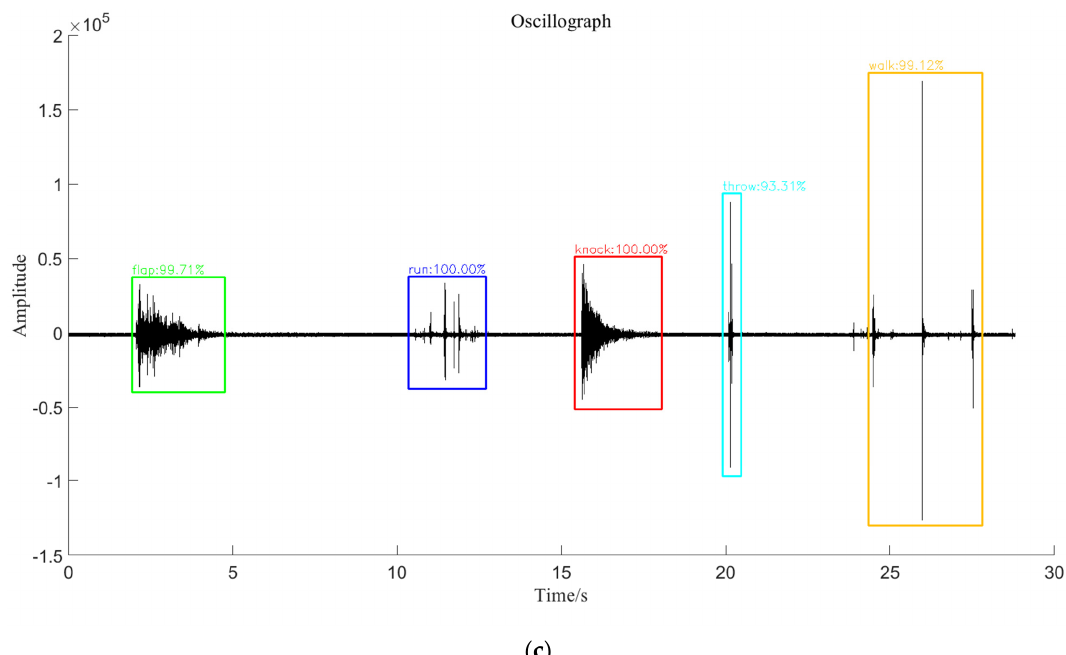
Figure 18. Comparison of the prediction results of different algorithms for each type of signal; ( a ) the original waveform; ( b ) the prediction result of YOLOv4; and ( c ) the prediction result of the method proposed in this paper.